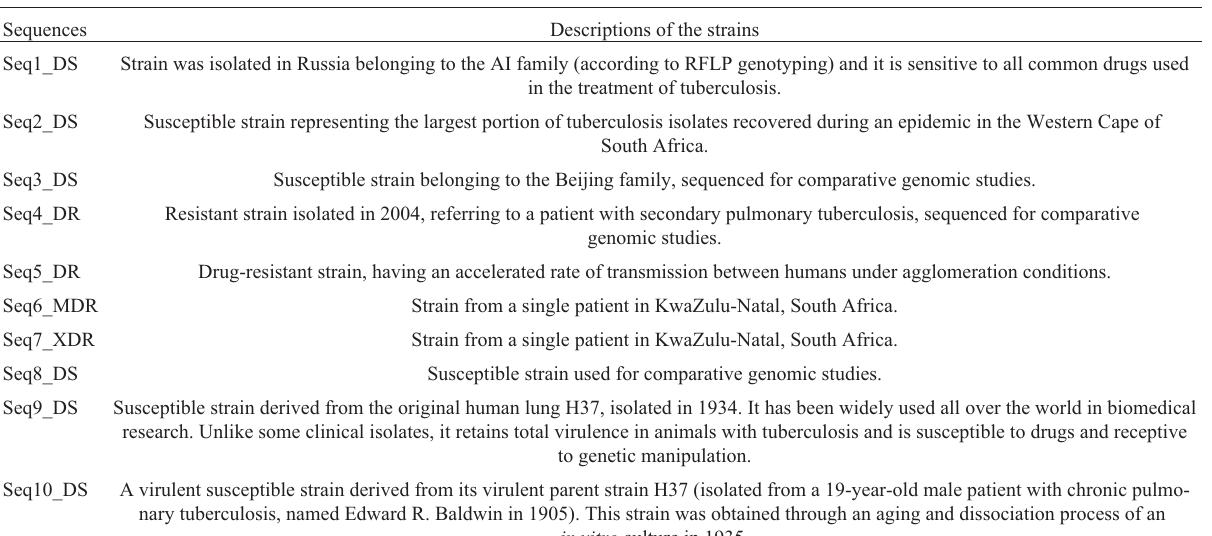
Table 1 - Descriptions of the Mycobacterium tuberculosis strains. Sequences Descriptions of the